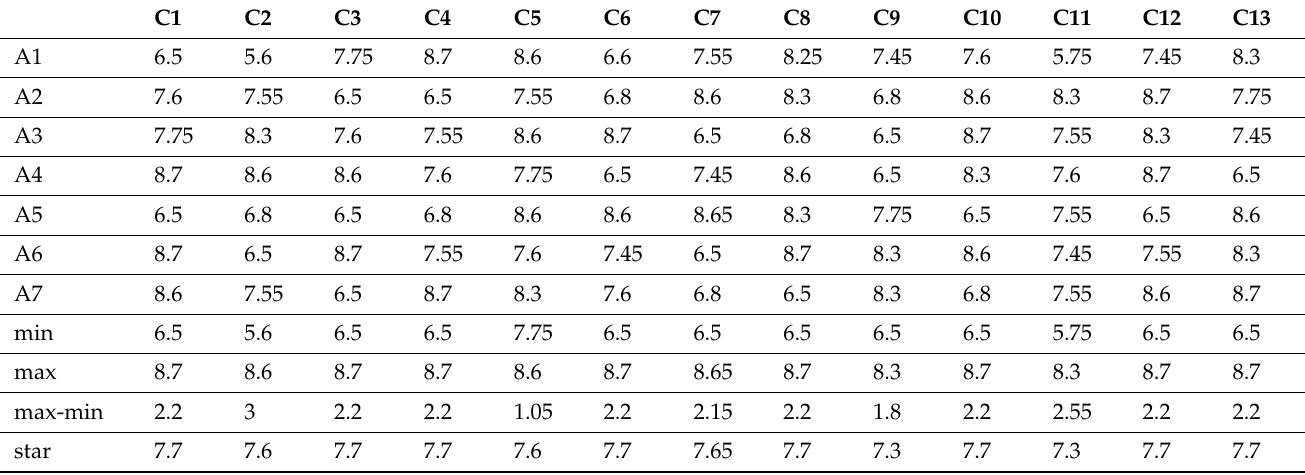
Table 8. Decision matrix of the gray relational analysis (GRA).